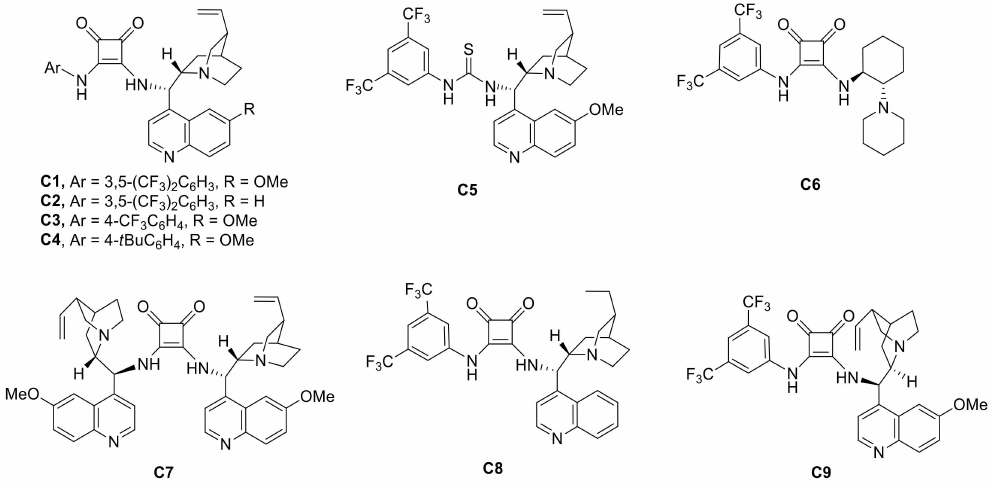
Figure 3. The screened